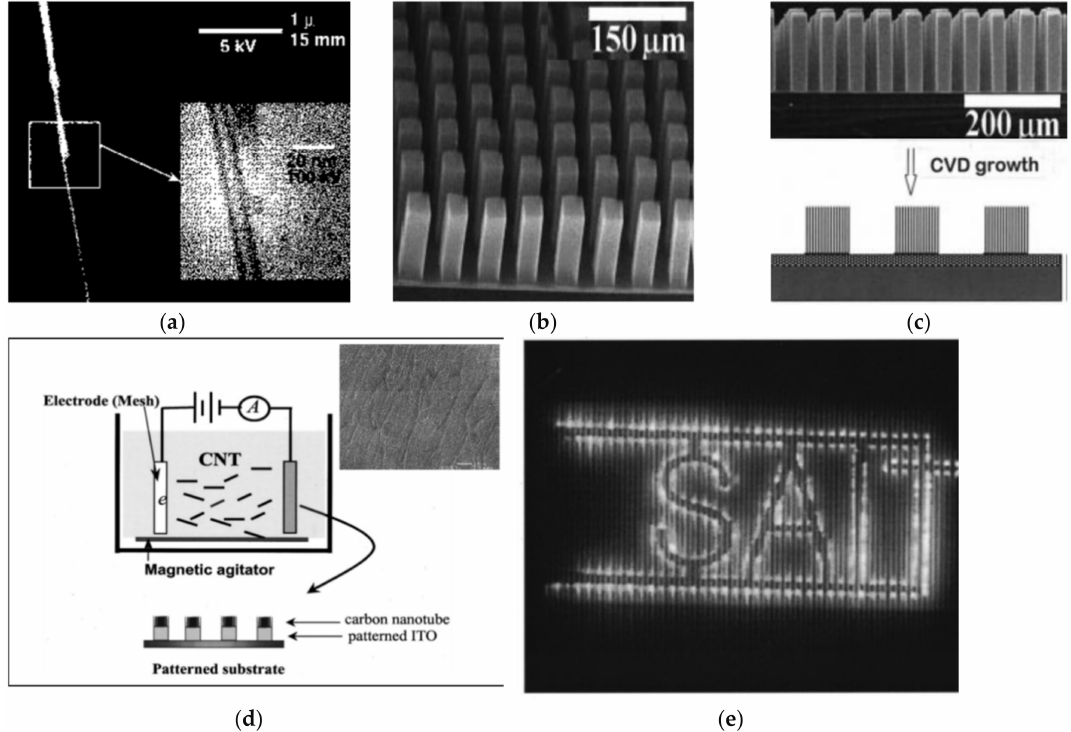
Figure 2. First approaches toward CNT field-emission (FE) cathodes: ( a ) a single CNT attached to a stalk—a high-resolution SEM image and transmission electron microscope (TEM) image (inset) (reprinted with permission from [80]); ( b , c ) synthesized and aligned arrays of CNT forest (reprinted with permission from [52])—SEM images of CNT towers ( b ) and its side-view variation ( c ), and the schematic cross-section illustration of the array (c—lower image); ( d ) CNT film deposited by electrophoresis—a schematic illustration presenting the process (reprinted with permission from [82]) with an SEM image of the deposited CNT by electrophoresis (insert view) (reprinted with permission from [81]); ( e ) the working FED from CNTs deposited by electrophoresis (reprinted with permission from [82]).